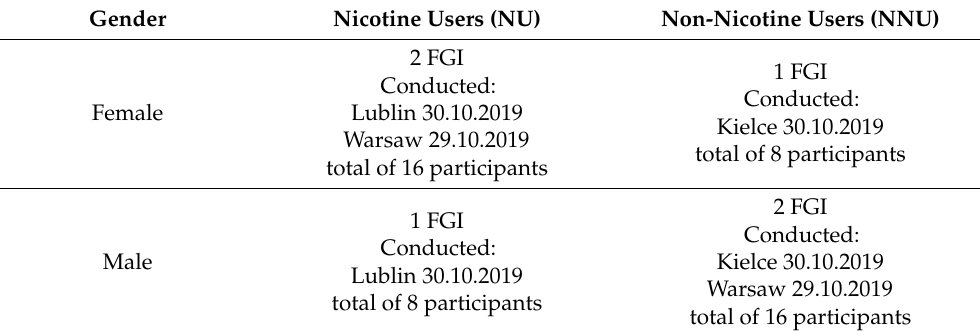
Table 2. Focus Group Interviews (FGI)